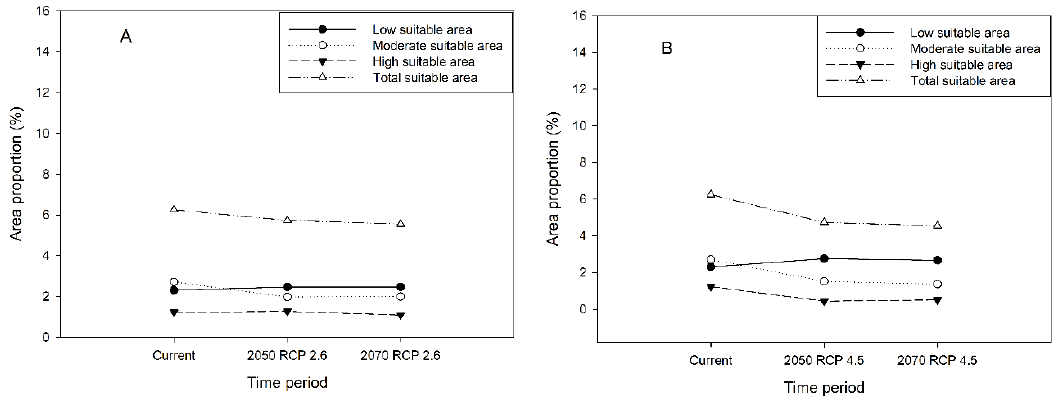
Figure 8. The change in area proportion (%) from current to 2070s under RCP2.6 ( A ) and under RCP4.5 ( B ).